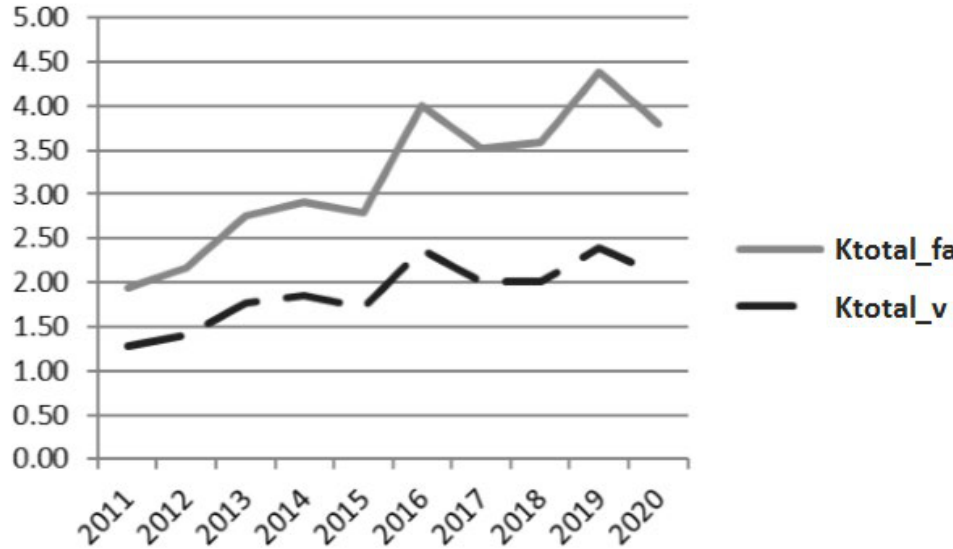
Figure 11. CLMP value dynamic for Boliden AB. CLMPfa—CLMP based on the total fixed assets; CLMPv—CLMP based on the total cost of machinery and equipment.